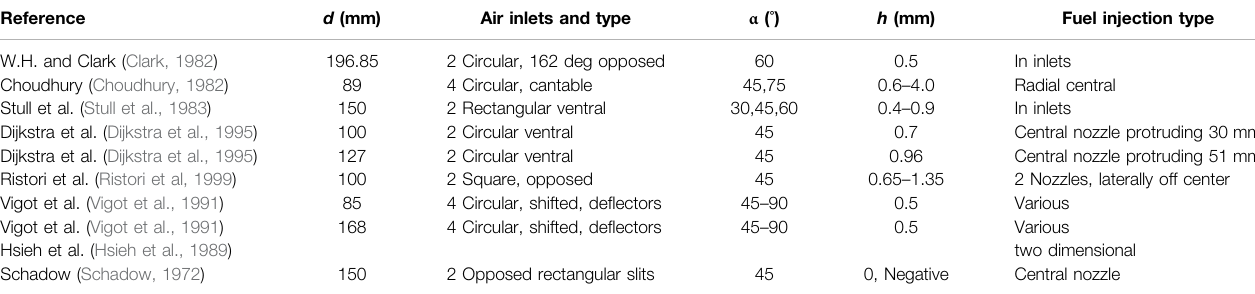
TABLE 1 | Geometric parameters and test conditions of the previous experiments.